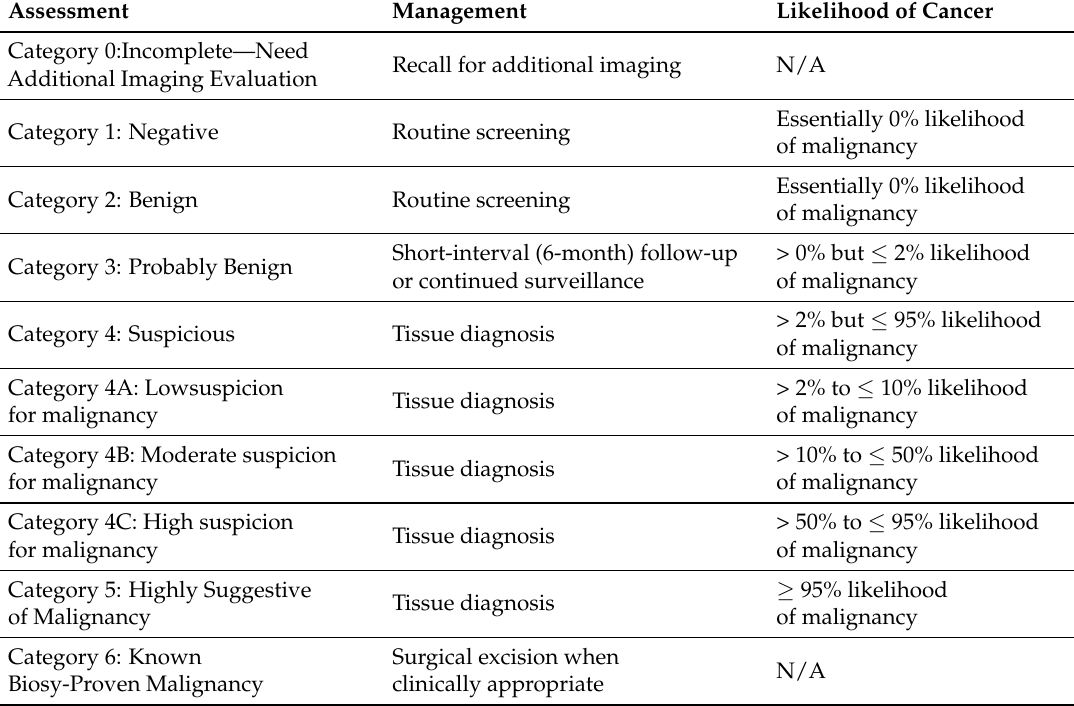
Table 1. Concordance between BI-RADS assessment categories and management recommendations